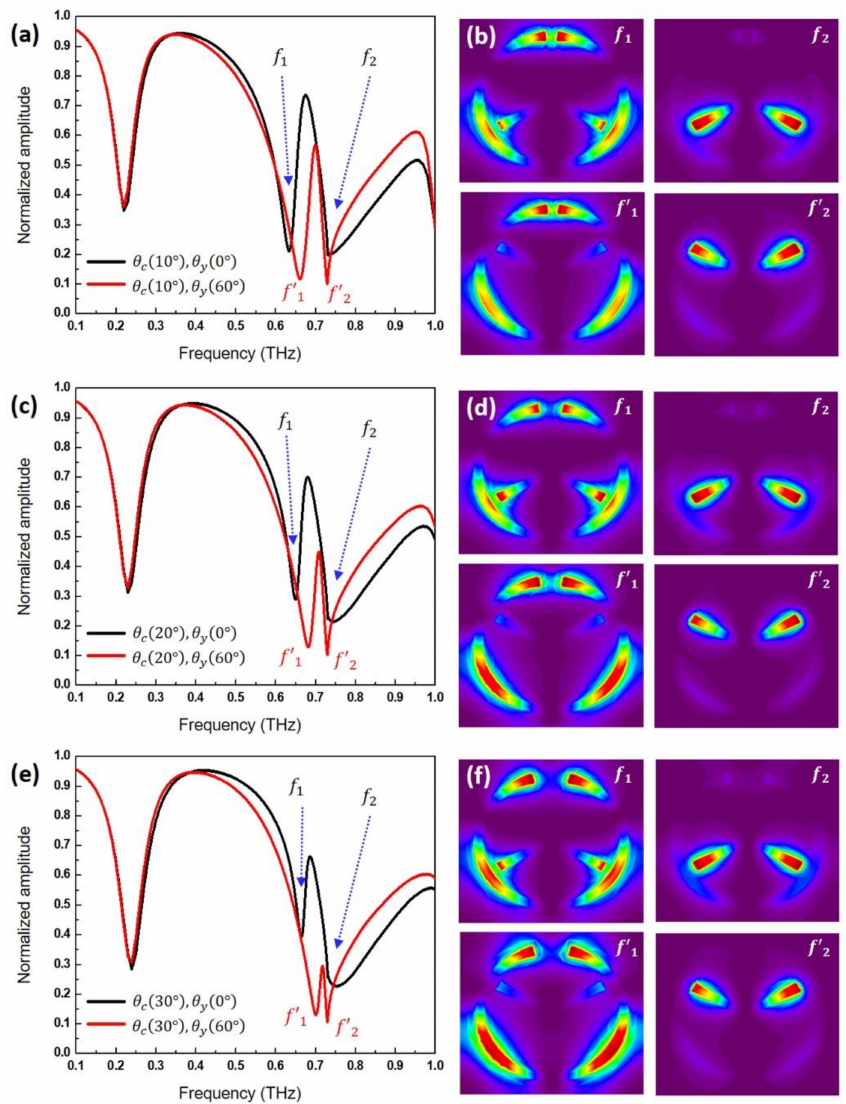
Figure 3. ( a , c , e ) Simulated THz amplitude spectra in the meta-rotamers consisting of the C-shaped SRR and Y-shaped rod meta-atoms, for the two different states of the meta-rotamers with rotation angles of θ y = 0 ◦ and 60 ◦ , as shown by the black and red solid lines, respectively. Each THz amplitude spectra were simulated in the three types of samples with different angular gaps of θ c = 10 ◦ , 20 ◦ , and 30 ◦ , as shown in ( a , c , e ), respectively. ( b , d , f ) Spatial electric near-field distributions for the meta- molecules at the resonances of f 1 , f 2 , f (cid:48) and f (cid:48) . For the three types of samples with different angular 2 1 gaps of θ c = 10 ◦ , 20 ◦ , and 30 ◦ , f 1 = 0.63, 0.65, and 0.66 THz, f 2 = 0.74, 0.74, and 0.74 THz, f (cid:48) = 0.66, 1 0.68, and 0.70 THz, and f (cid:48) = 0.73, 0.73, and 0.73 THz, 2